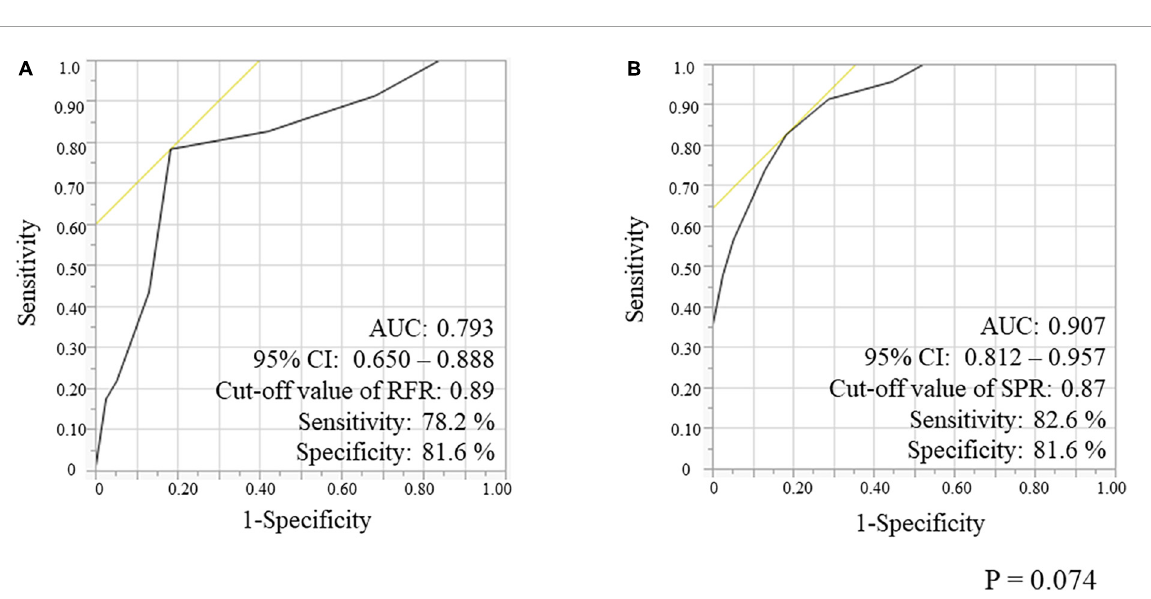
FIGURE5 Receiver-operating characteristic (ROC) curves for RFR (A) and SPR (B) , using FFR < 0.80 as the reference standard variable in the gray-zone from 0.86 to 0.93 of RFR. RFR, resting full-cycle ratio; SPR, saline-induced Pd/Pa ratio; FFR, fractional flow reserve; AUC, area under the